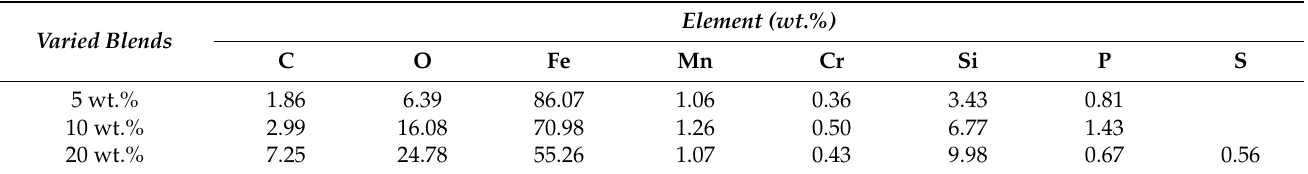
Table 3. EDS analysis results of the lower cylinder liner surface lubricated by emulsified biomass fuel with different